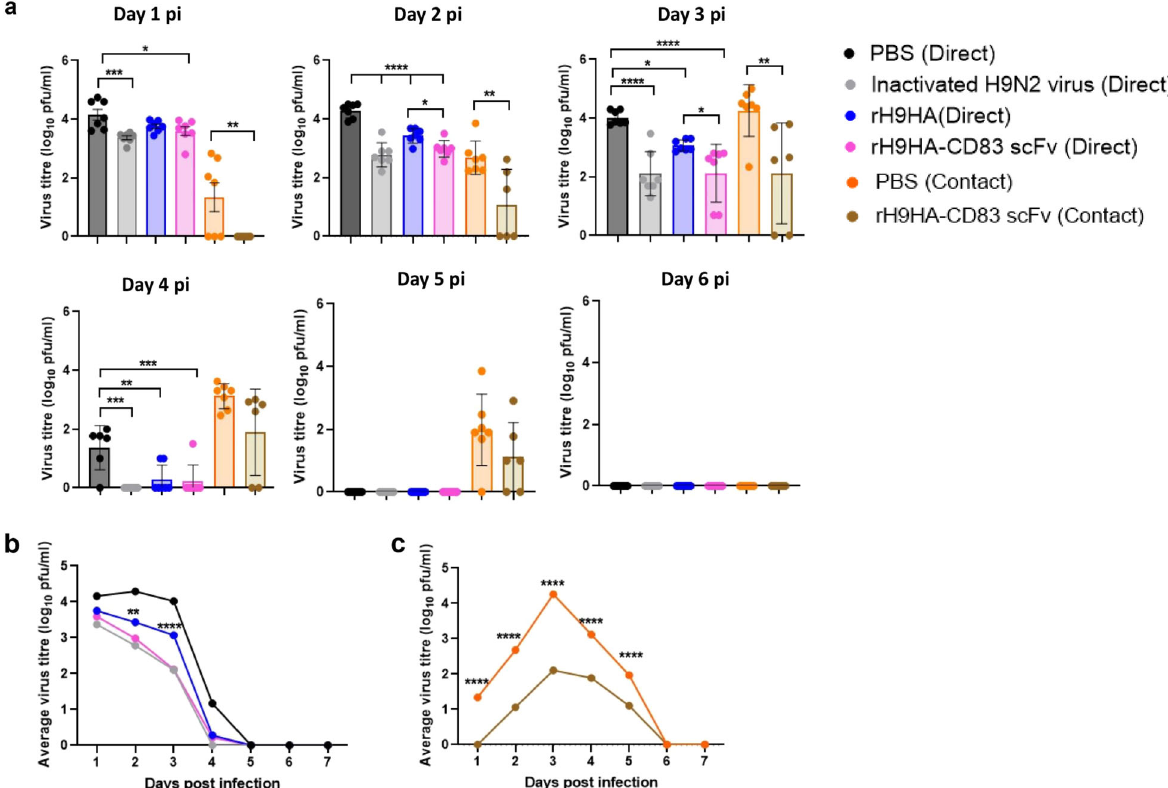
Fig. 9 Challenge virus shedding pro fi les from the buccal cavity of vaccinated and PBS treated control chickens infected with H9N2 virus (UDL 01/08). Groups of 7-day-old chickens ( n = 7) were immunised with 35 µg of recombinant rH9HA-CD83 scFv equivalent to 25 µg of recombinant rH9HA (equimolar concentration). The second vaccine dose as boost was given on day 7 post primary vaccination. The chickens were challenged with 100 μ l of 1 × 10 7 pfu/ml H9N2 virus (UDL 01/2008) after 7 days post boost vaccination. Some of the vaccinated and control birds were left unchallenged to serve as contacts. Swabs were taken from the buccal cavity until day 7 post infection and the amount of live virus particles recovered from swabs was titrated via plaque assays and presented as plaque-forming units (PFU)/ml. a Shedding pro fi les of each chicken from the buccal cavity at different days post infection are indicated by a single coloured dot. b The average shedding pro fi le from the buccal cavity per group for directly infected birds. c The average shedding pro fi le from buccal cavity per group for contact birds. Data are presented as mean ± SD for ( a ) and analysed by one-way ANOVA followed by Tukey ’ s multiple comparison test for ( a ) and by unpaired t-test for ( b, c ). For ( b ) the asterisks represent signi fi cant difference between rH9HA and rH9HA-CD83 scFv (direct) groups. **** p